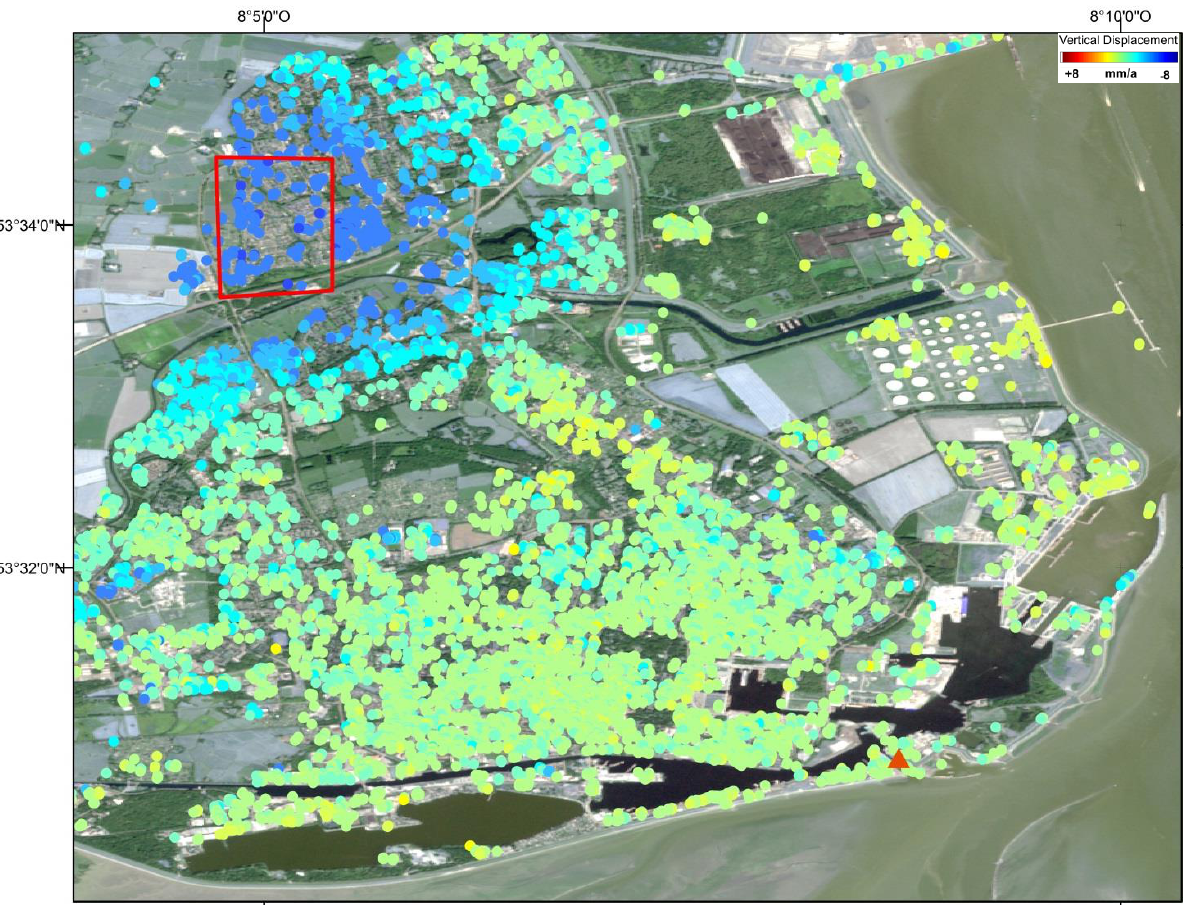
Figure 3: Study area of WH. Red rectangle location of strongest motion, red triangle location of gauging station with installed